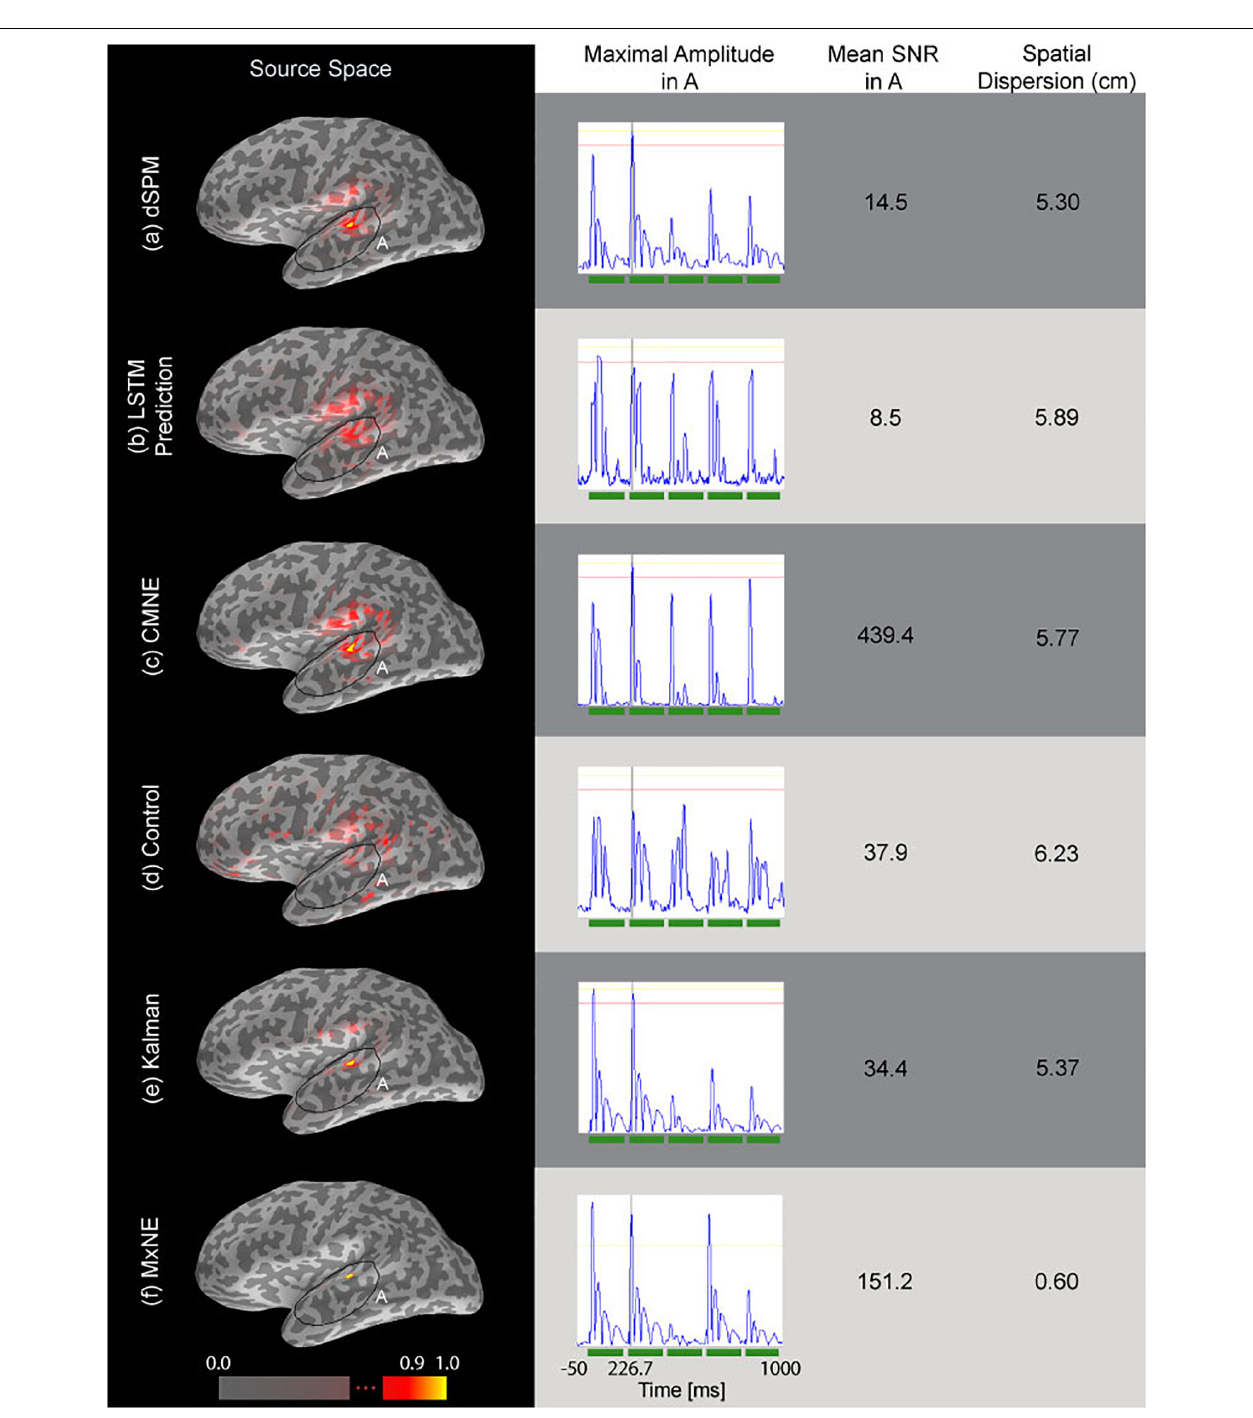
FIGURE 5 | Source estimations based on simulated data (20 averaged epochs) are shown in the source space column. The second column from the left shows the time traces of the estimated dipole with maximal amplitude within the marked area A as depicted in the first column. The third column shows the estimated SNR of the respective source reconstruction method (Eq. 26) and the fourth column shows the spatial dispersion of the estimates (Eq. 24). The tested source estimation methods are divided into rows: (a) dSPM estimate ˆ q t , (b) LSTM network prediction ¯ b (cid:0) ˆ q t (cid:1) , (c) CMNE estimate b (cid:0) ˆ q t (cid:1) , (d) control estimate, which averages the 80 previous estimates and uses that average to correct the current dSPM estimate based on the average of 20 epochs, (e) Kalman estimate, (f) MxNE estimate. All estimates were rectified and normalized to their peak value.